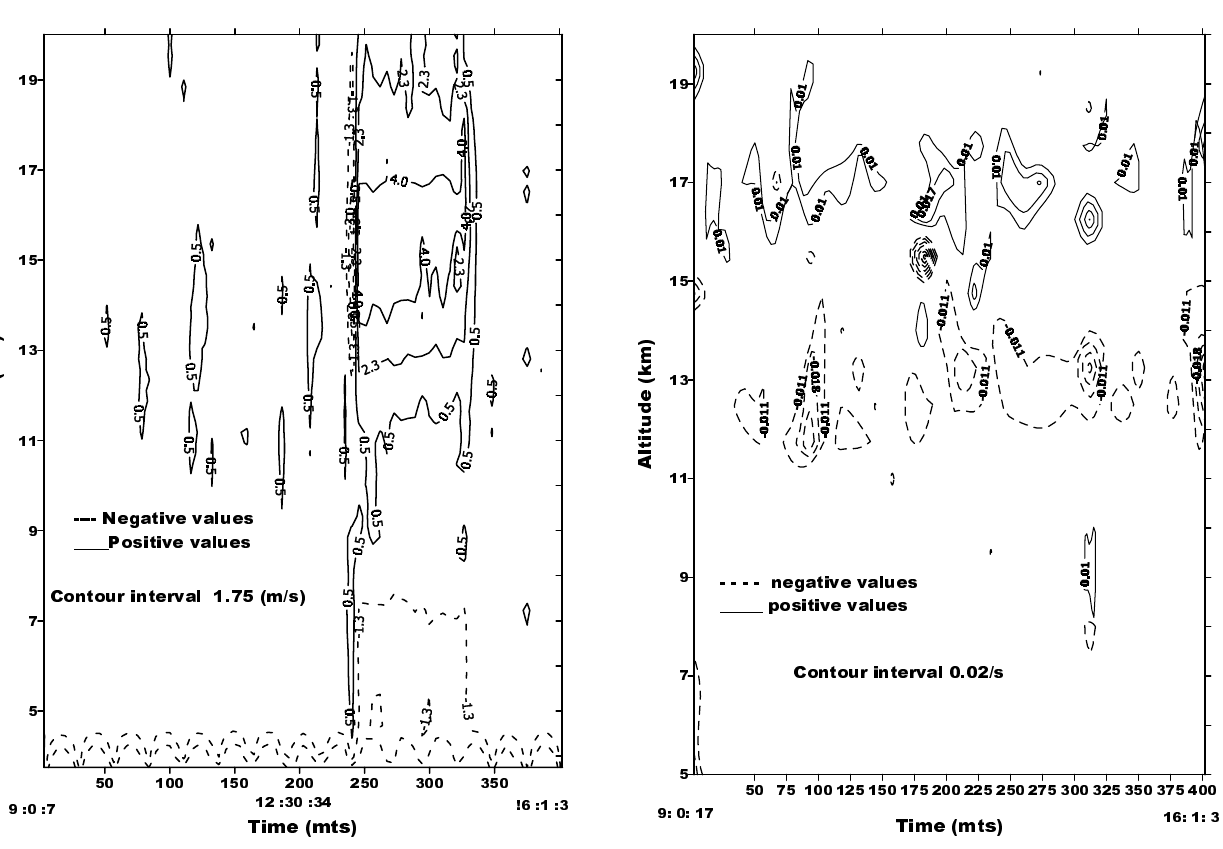
Fig. 2. Evolution of vertical wind with time and altitude on 28 Au- gust 1999, 09:00 to 16:00LT. Full lines indicate upward wind and dashed lines indicate downward wind. Contour interval is 1.75m/s.